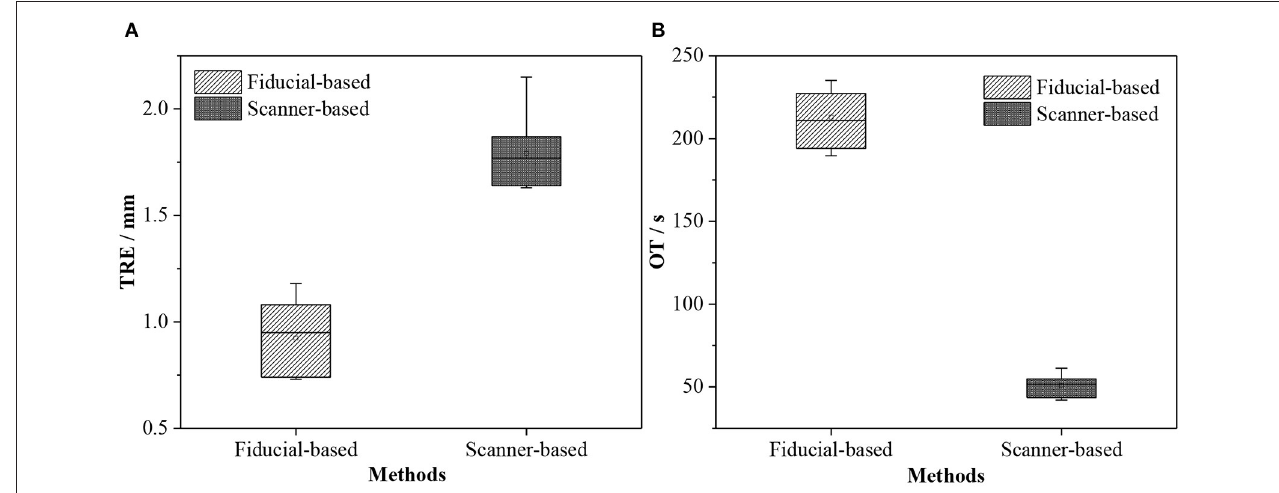
FIGURE 13 | Box plots of TRE and OT obtained by different registration methods. (A) TRE and (B)